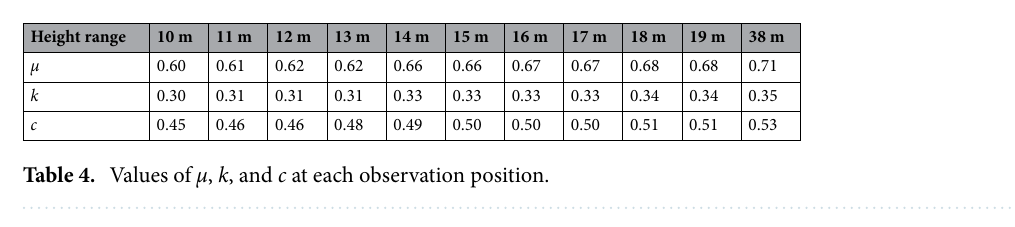
Figure 10. Three type of probability distribution of wind speed at the observed altitude.